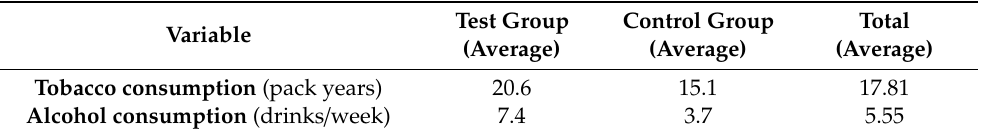
Table 2. Average tobacco and alcohol consumption in both groups.